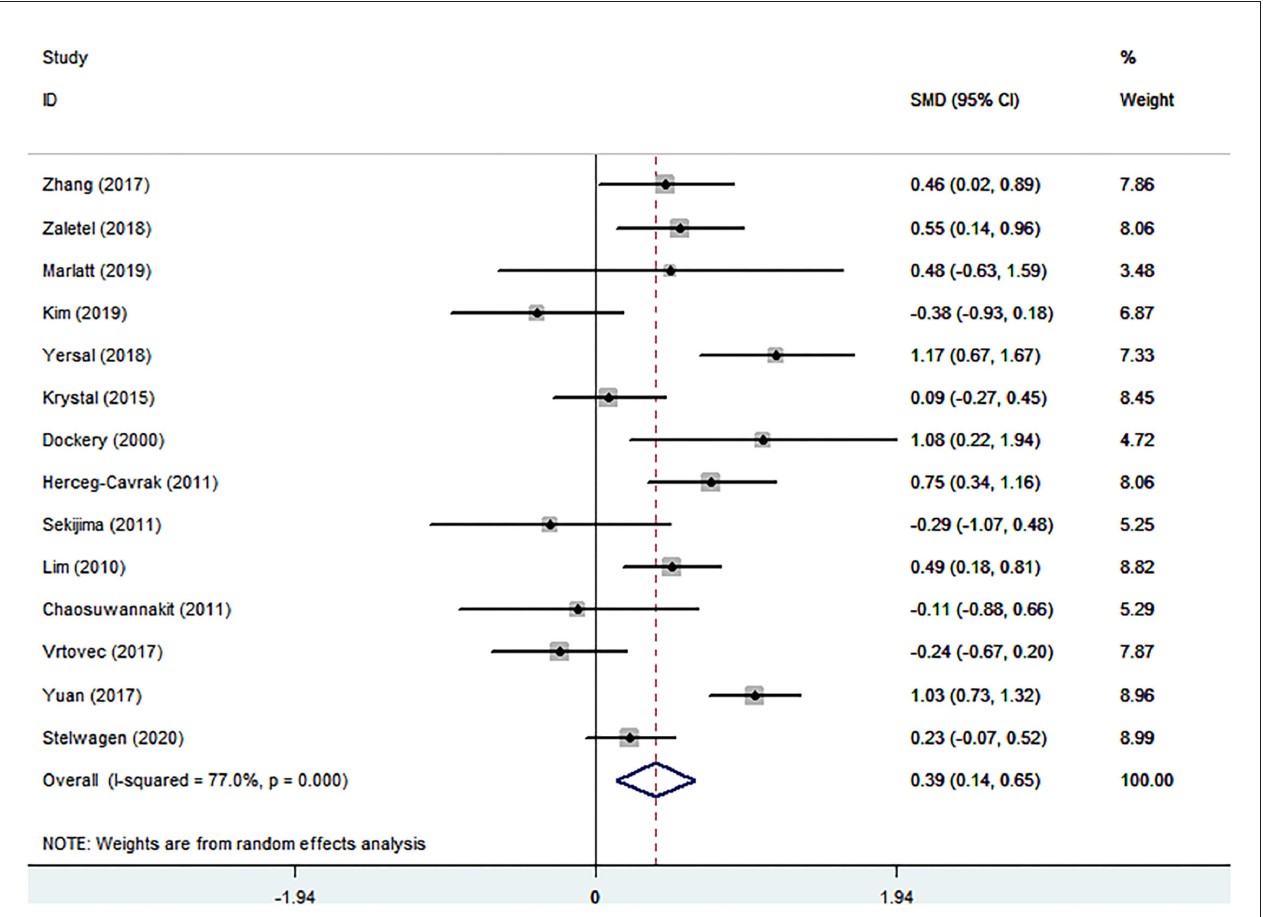
FIGURE 3 | Forest plot of pulse wave velocity in patients with cancer and controls without cancer. SMD, standard mean difference; CI, confidence